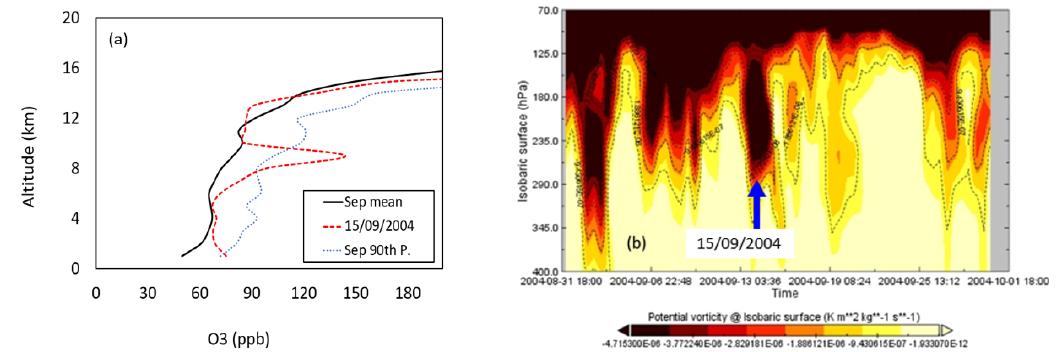
Figure 5. ( a ) Ozone troposphere profile over Irene on 15 September 2004. ( b ) Potential vorticity at Isobaric surface over Irene on July 2004 (from MERRA-2). Solid line in Figure 5a indicates monthly O 3 average composite, broken line indicates O 3 event and dotted line indicate 90th percentile composite. Colours in Figure 5b indicates the level of potential vorticity, black indicates high potential vorticity of more than 3 Km − 2 kg − 1 s − 1 while yellow indicates potential vorticity of less than 2 Km − 2 kg − 1 s − 1 . Blue arrow in Figure 5b indicates the event that is associated with O 3 profile in Figure 5a.